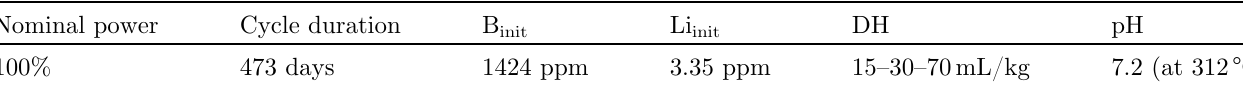
Table 2. Parameters of the reference cycles.